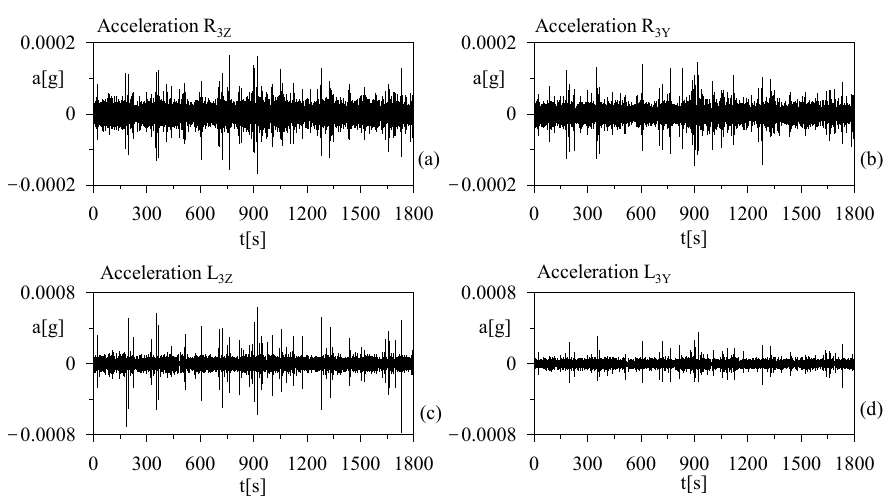
Figure 8. Examples of accelerometric measurements recorded in the span n3 in the following corresponding positions and directions: ( a ) R 3Z , ( b ) R 3Y , ( c ) L 3Z , and ( d ) L 3Y .